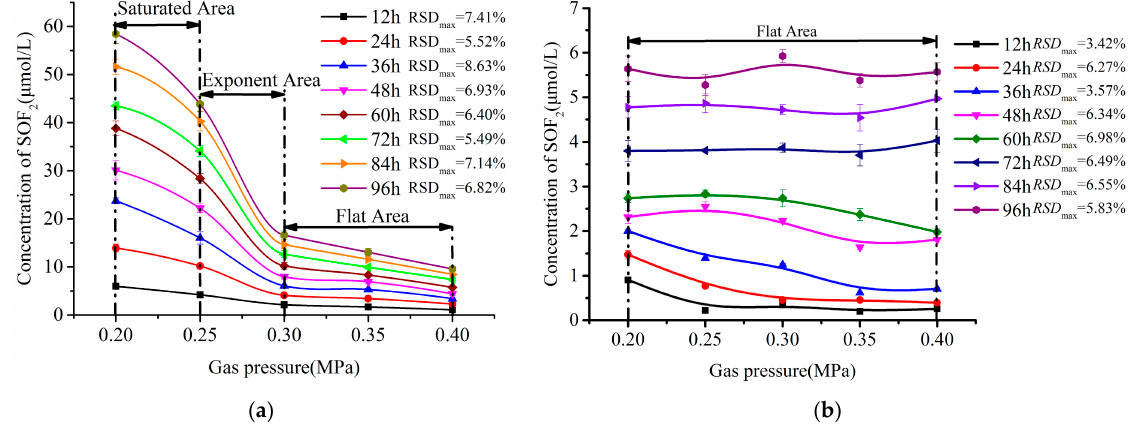
Figure 4. Correlation between SOF 2 concentration and pressure: ( a ) Protrusion and ( b )